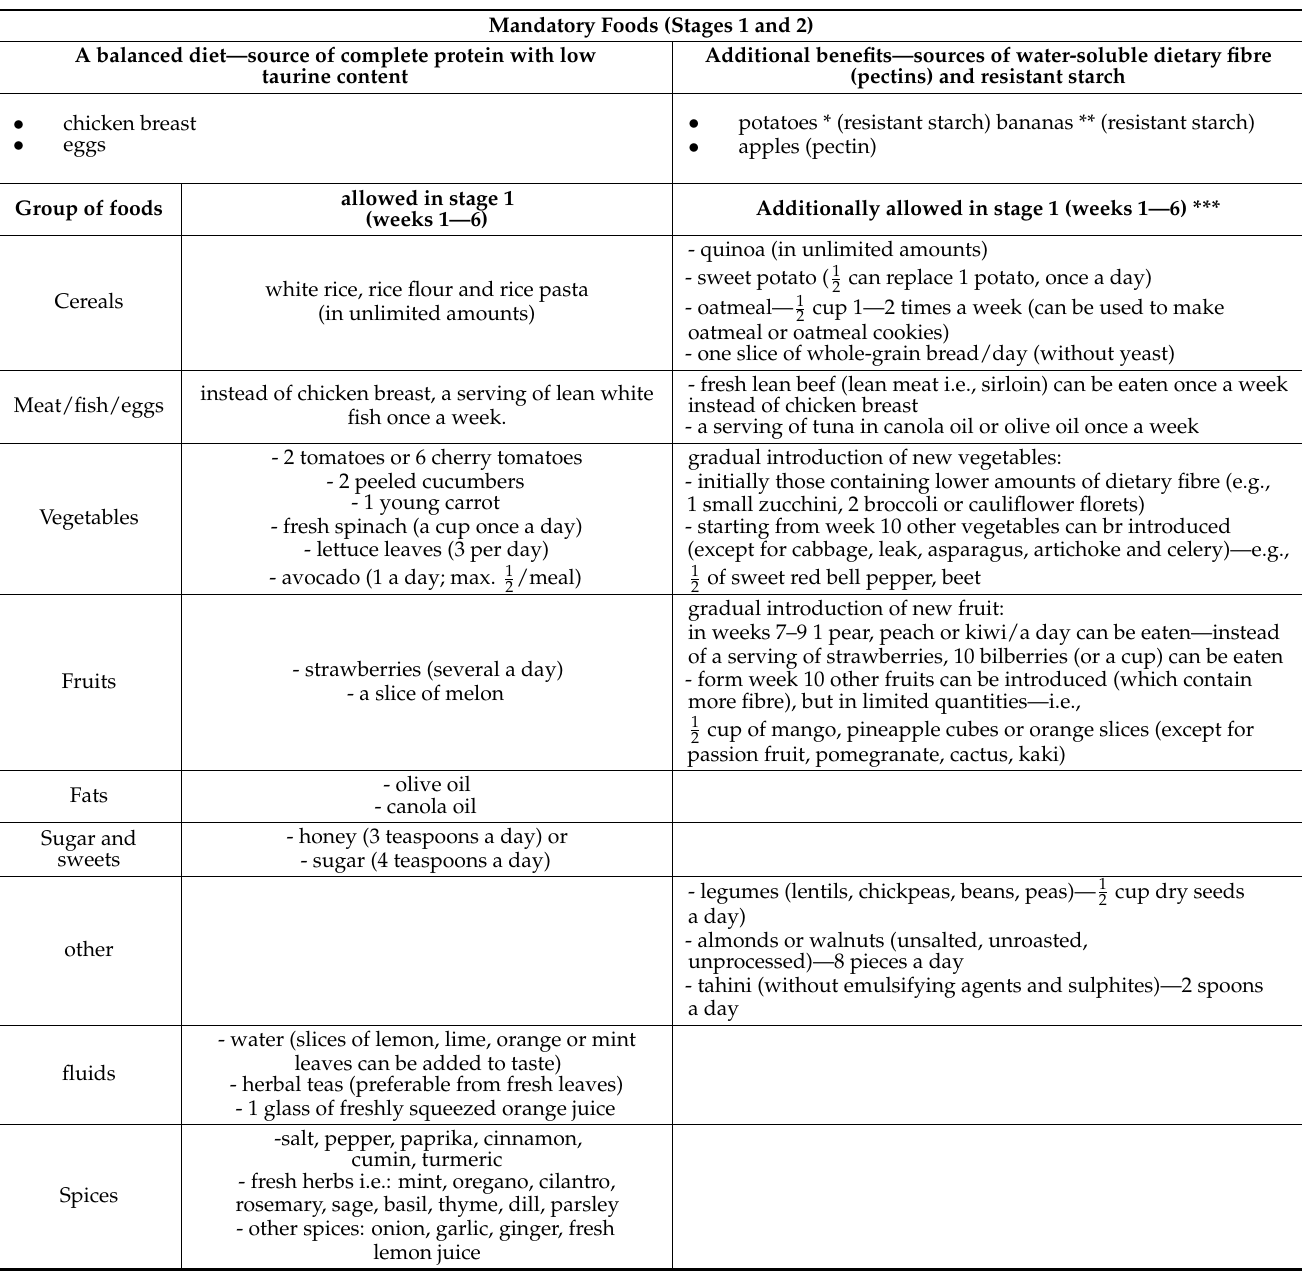
Table 2. Foods mandatory/allowed during the induction phase of CDED (stages 1 and 2). Mandatory Foods (Stages 1 and